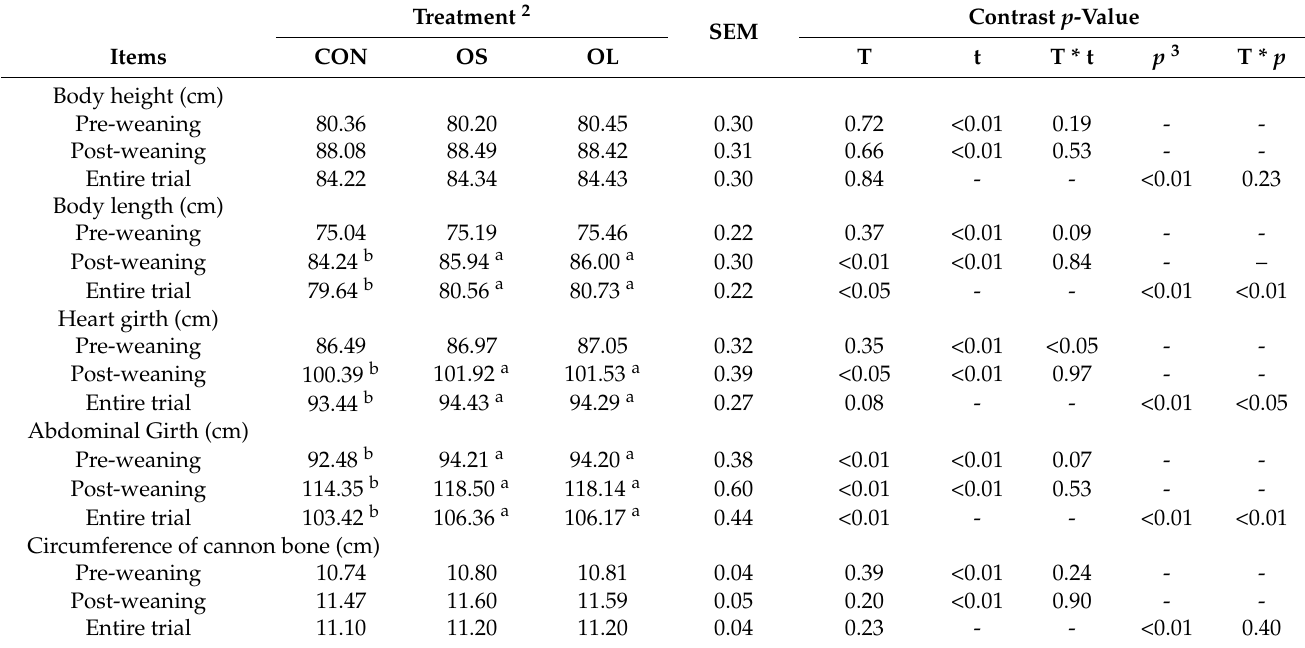
Table 2. Effects of different length of hay supplementation in Holstein dairy calves on body structural growth in different periods of study 1